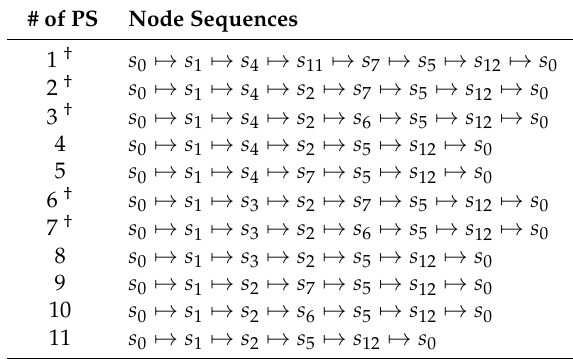
Table 4. Node sequences for initial marking vector [ p 0 p 1 p 2 p ] = [ 0 0 2 0 ] under a maximal step firing